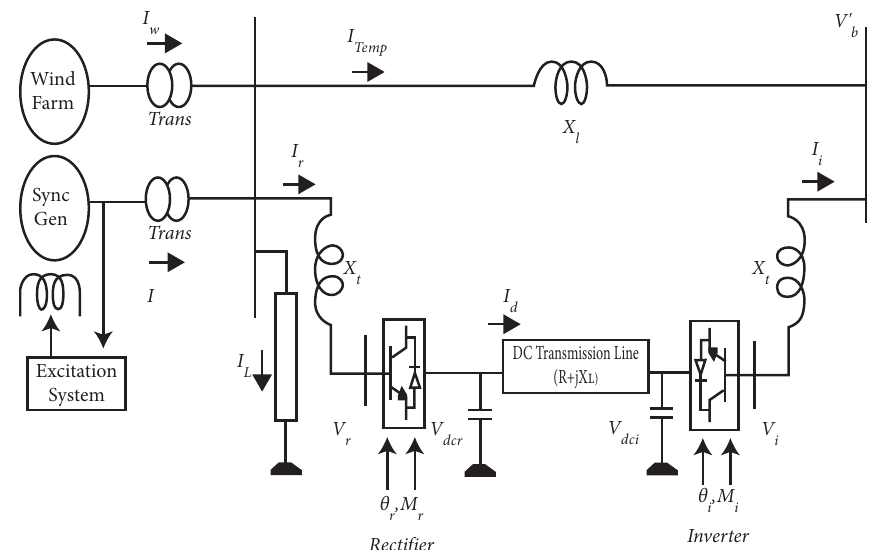
Figure 1: The power system under